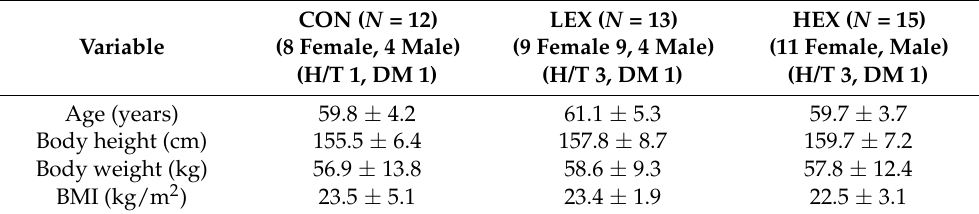
Table 1. Subject